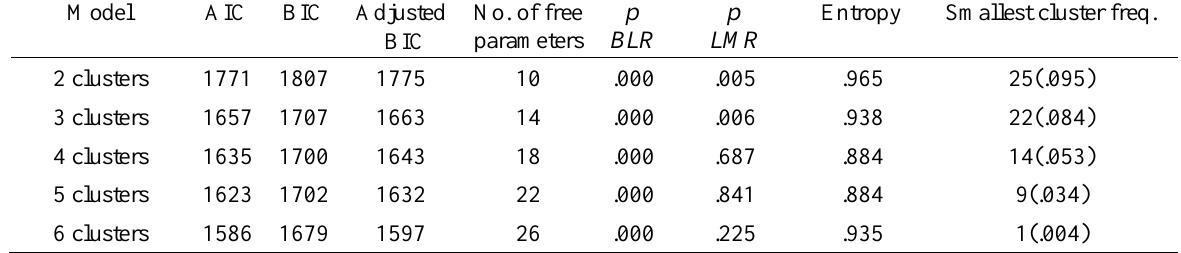
Table 1 Fit indices for different models with number of clusters ranging from 2 to 6. Model